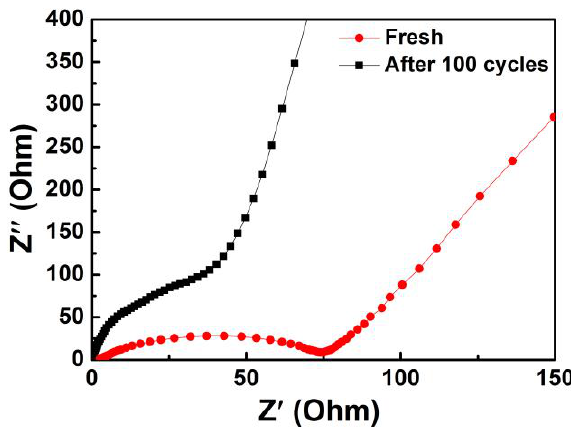
Figure 12. Impedance plots of the C@Fe 2 O 3 composite when fresh and after 100 cycles.